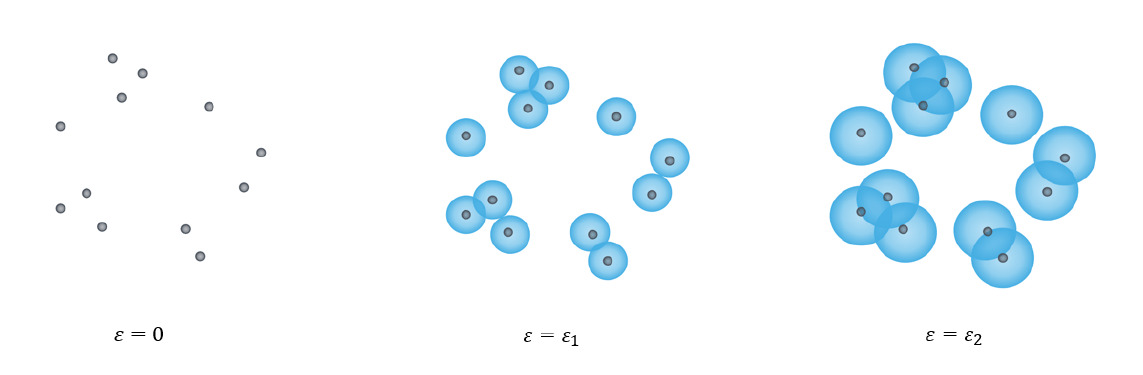
Figure 2. Diagram illustrating circular intersections and linked point clouds required to build a Simplicial